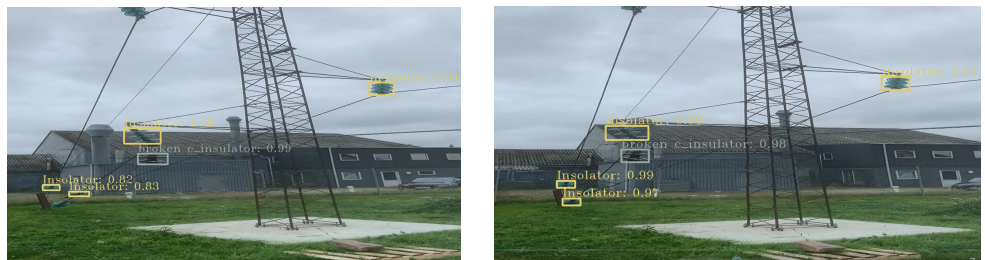
Figure 18. Realtime onboard fault detection by using the deep learning algorithm on Nvidia AGX NX.